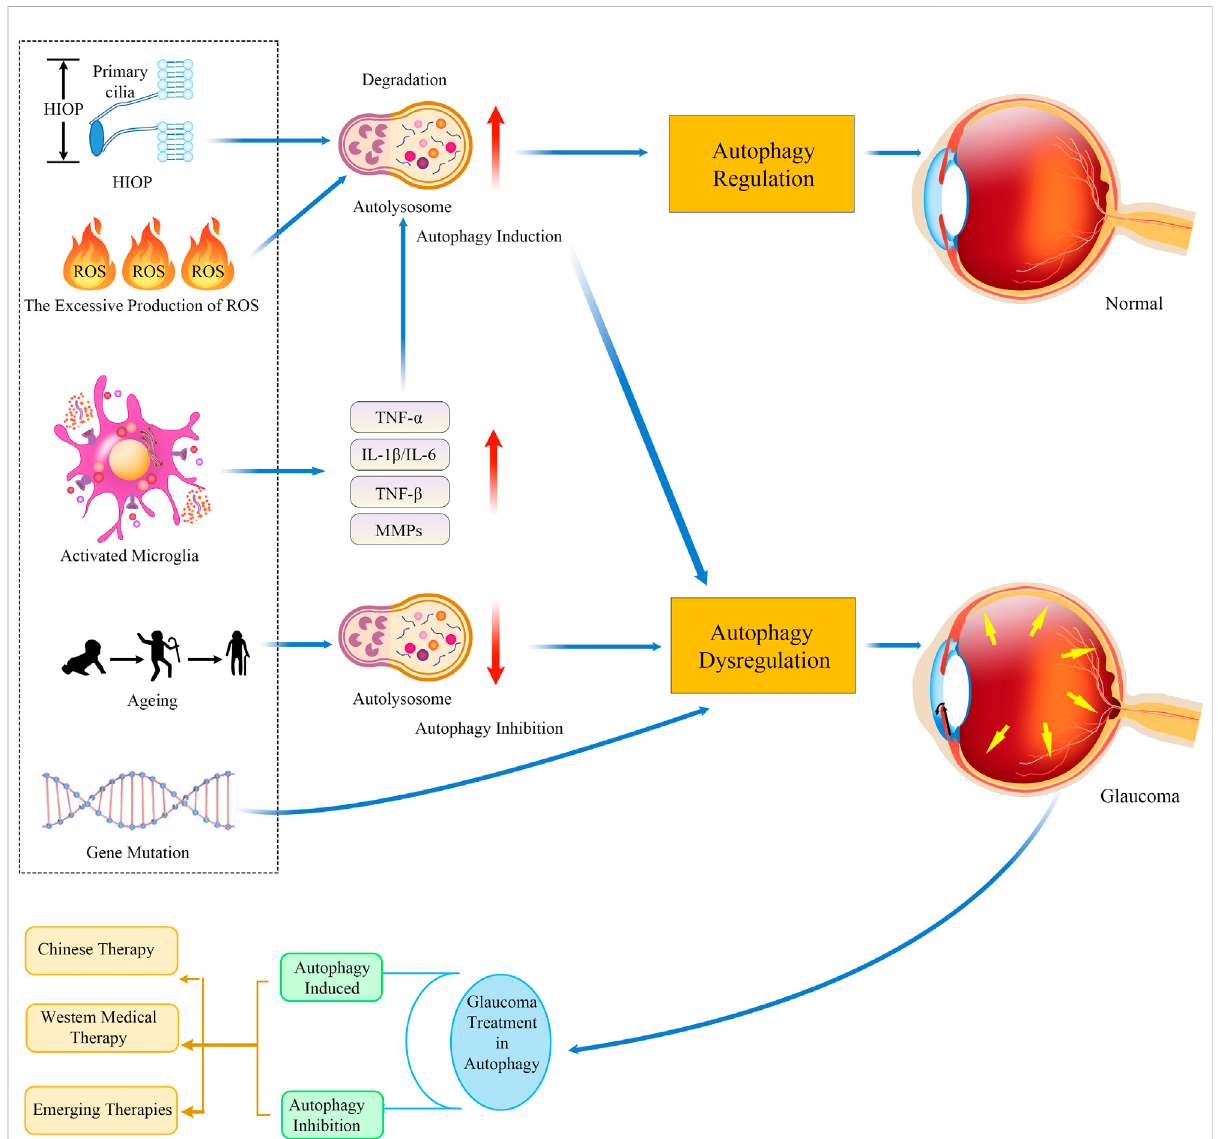
FIGURE 2 Timeline of autophagy regulation in glaucoma pathogenesis and treatment. The underlying mechanisms of glaucomatous neurodegeneration involve multiple factors, including HIOP, mitochondrial dysfunction, oxidative stress, immune-mediated neuroin fl ammatory responses, aging, and gene mutation. Strategies targeting the known mechanisms of autophagy might be neuroprotective and, thus, work for treating glaucoma. Abbreviations: HIOP, high intraocular pressure; TNF- α , tumor necrosis factor-alpha; IL-1 β , interleukin-1 beta; IL-6, interleukin-6; TGF- β , transforming growth factor- β ; MMP, matrix